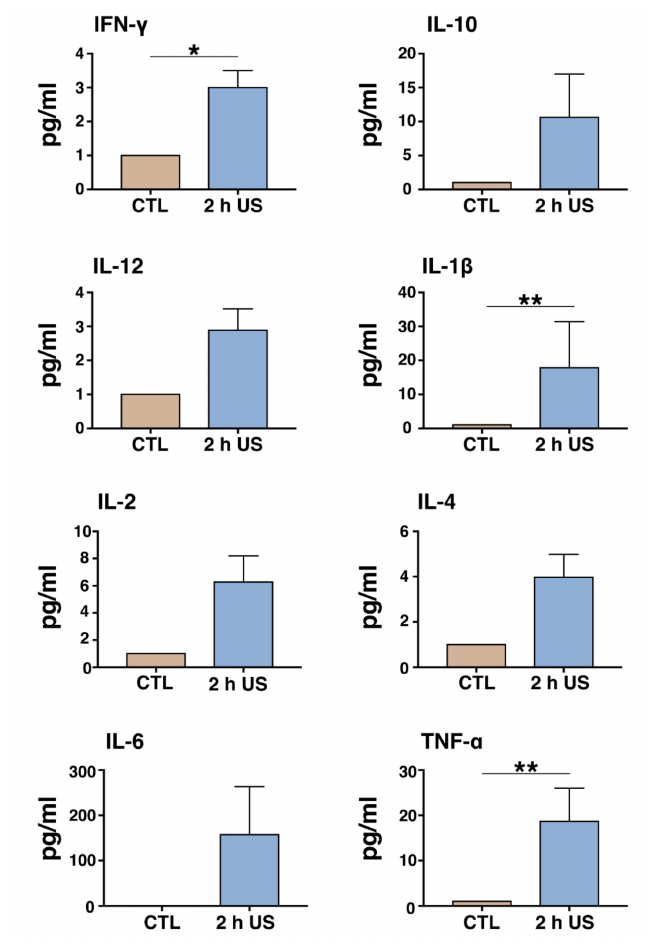
Figure 2. Enzyme linked immunosorbent assay (ELISA) results of the V-PLEX Proinflammatory panel 1. IFN- γ was significantly upregulated 3-fold; IL- β was significantly upregulated by 16-fold, while TNF- α was upregulated 17-fold compared to control, non-low intensity continuous ultrasound (LICU)-treated samples. IL-10, IL-12, IL-2, IL-4, IL-5, and IL-6 did not significantly increase following LICU treatment. **: p < 0.005; *: p <